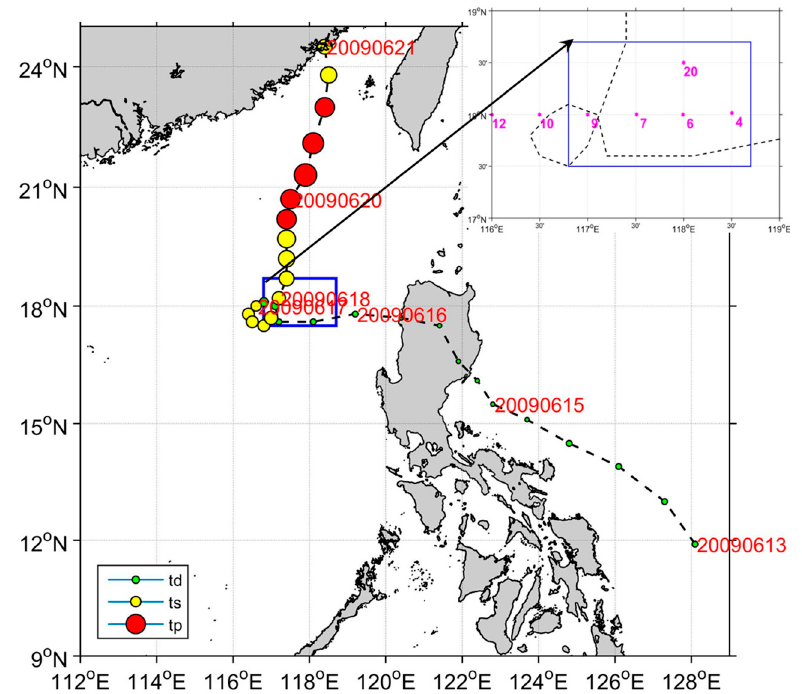
Figure 1. Map of the study area and typhoon path (the blue box represents the study area; black line means the path of typhoon; the green, yellow, and red dots represent the tropical depression (td), tropical storm (ts), and typhoon (tp), respectively; the pink points and pink numbers represent the station positions and station names).